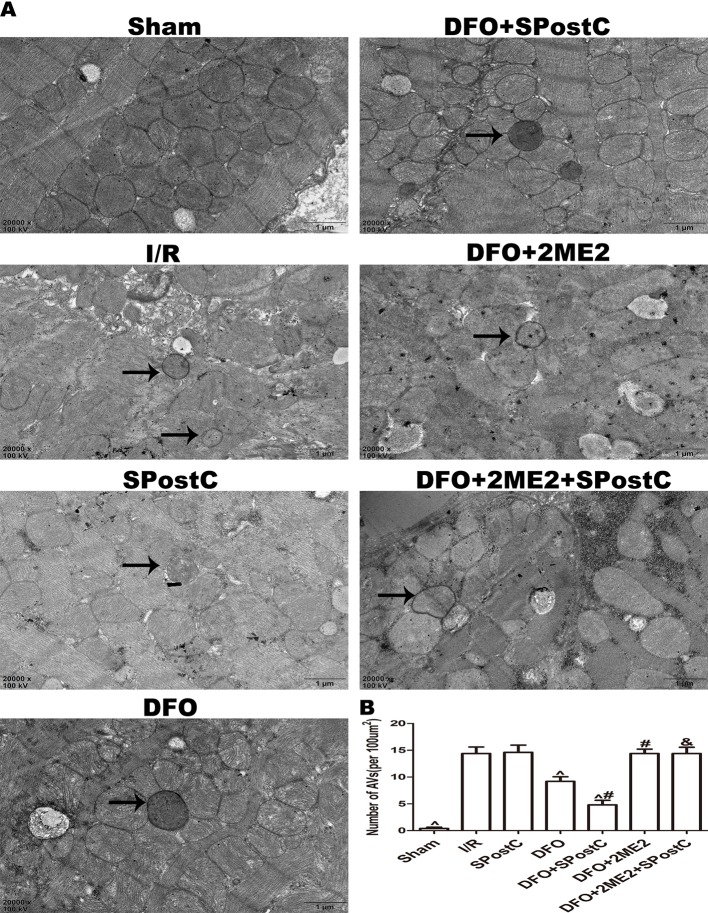
After deferoxamine (DFO) treatment, SPostC reduced the damage of mitochondrial ultrastructure and the accumulation of autophagosomes in diabetic state. (A) Representative transmission electron micrographs show mitochondrial ultrastructure and autophagosomes in the ischemic myocardial after 2 h of reperfusion. (B) Quantitative analysis of autophagosome. Autophagosome are indicated by the black arrow. The transmission electron microscope image was magnified 20,000 times. (^P < 0.05 vs I/R, #P < 0.05 vs DFO, &P < 0.05 vs DFO+SpostC) (n = 5/group).